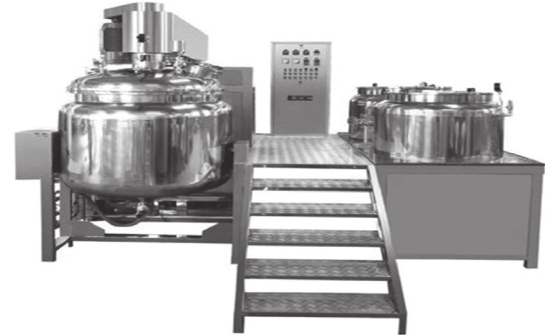
Figure 8: Shear mixer.